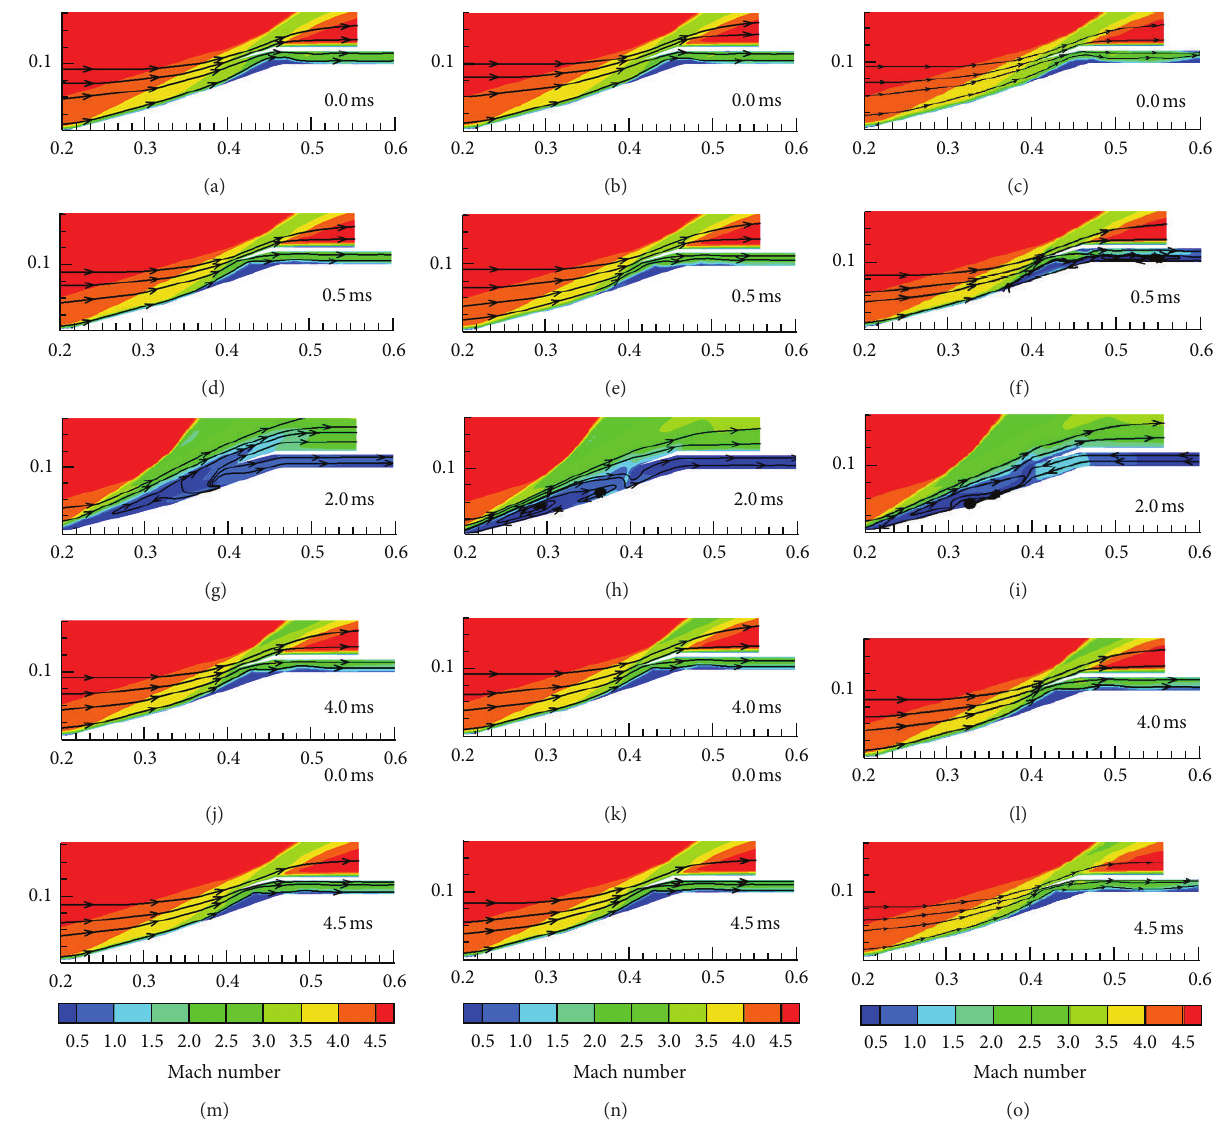
Figure 7: Mach contours mixing with cross section 𝑍 1, 𝑍 2, and 𝑍 3 in a buzz